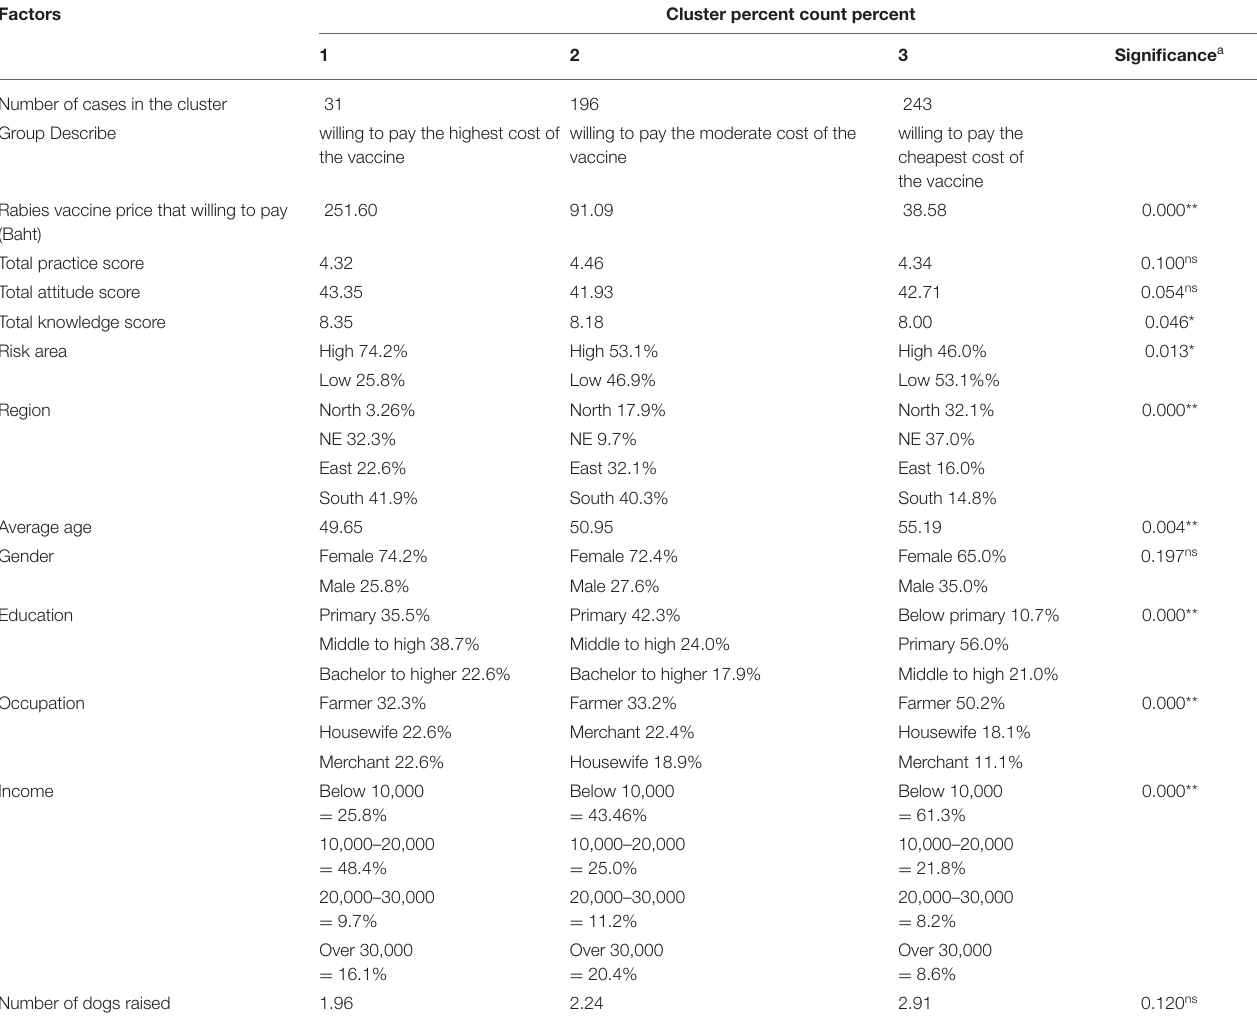
TABLE 7 | Clusters of income, education, and rabies vaccine price that willing to pay of dog owners regarding rabies control in Thailand.